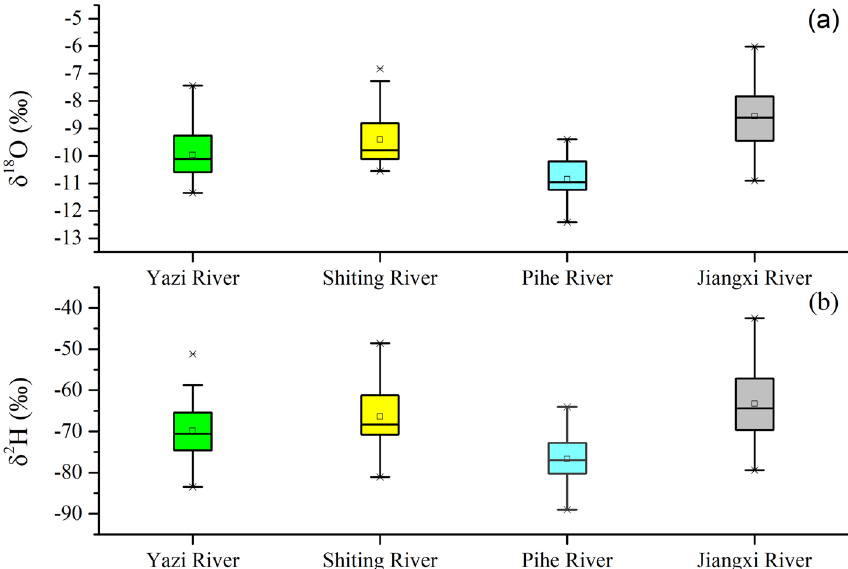
Figure 2. Box plots of spatial variation for δ 18 O ( a ) and δ 2 H ( b ) among Yazi River, Shiting River Pihe River and Jiangxi River. The box plot has lines at the lower quartile, median, and upper quartile values. The whiskers of the box are lines extending from each end of the box to show the extent of the rest of the data. The outliers of the box are data with values beyond the ends of the